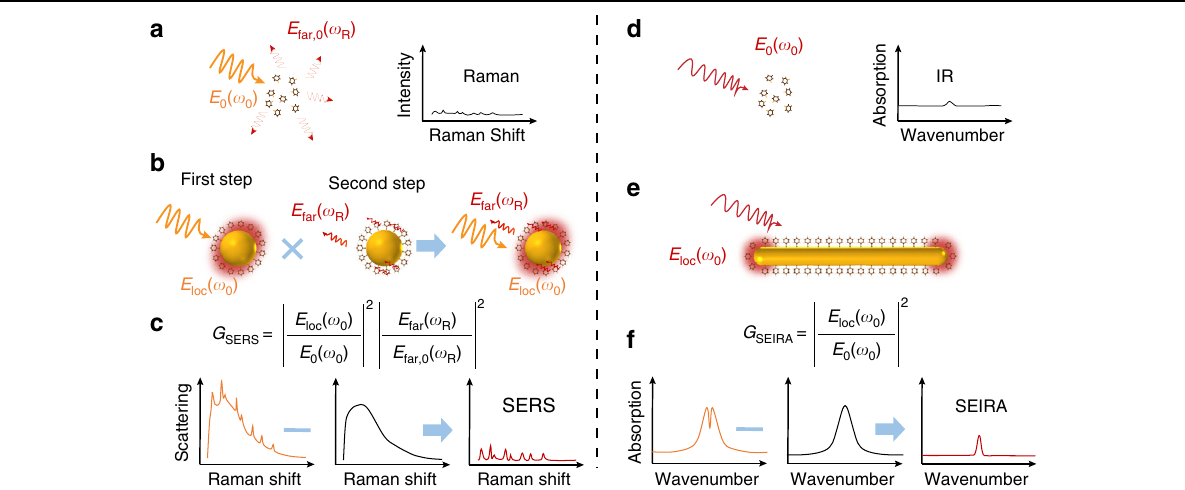
Fig. 3 Principles of SERS and SEIRA. a Normal Raman scattering E far ; 0 ω R ð Þ and Raman spectrum of molecules illuminated by narrow band laser. b Surface-enhanced Raman scattering from molecules adsorbed onto the metal nanosphere. Local fi eld E loc ω 0 ð Þ around metal nanosphere is enhanced by localized surface polasmon polaritons (LSP) around the metal nanosphere. The excitation and radiation ef fi ciency E far ω R ð Þ of Raman scattering from molecules are improved in the local fi eld via the interaction with LSP. Thus, the Raman scattering will be enhanced by G SERS . c Data processing for SERS spectrum. Raw spectrum (left) from molecules adsorbed on nanosphere contains photoluminescence (PL) spectrum (middle) and molecular SERS spectrum (right). d Normal IR spectrum of molecules illuminated by IR laser. e LSP around metal nanorod is excited by IR laser. Local fi eld E loc ω 0 ð Þ at the nanorod ’ s two ends is enhanced by LSP. IR absorption of molecules in the local fi eld is enhanced by G SEIRA . f Data processing for SEIRA. Raw spectrum (left) from molecules adsorbed on nanorod contains nanorod (middle) and molecular absorption (right). Owing to the coupling between the plasmon and the molecular vibration, the SEIRA spectrum (left) often shows a asymmetric peak or a dip when the molecules absorb IR